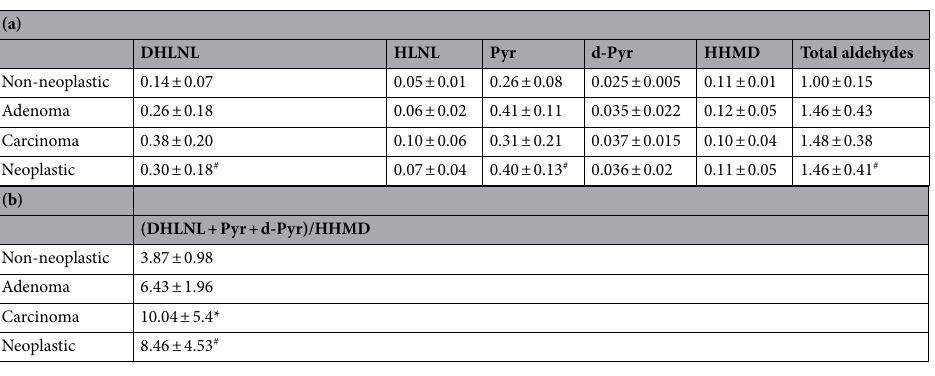
Table 5. Levels of immature reducible cross-links (DHLNL, HLNL, and HHMD) and mature non- reducible cross-links (Pry and d-Pyr) and their ratios. (a, b) DHLNL, dihydroxylysinonorleucine; HLNL, hydroxylysinonorleucine; HHMD, histidinohydroxymerodesmosine; Pyr, pyridinoline; d-Pyr, deoxypyridinoline. Total aldehydes = DHLNL + HLNL + 2 × Pyr + 2 × d-Pyr + 2 × HHMD. Values represent moles/mole collagen ± S.D (non-neoplastic, n = 5; adenoma, n = 7; carcinoma, n = 9; neoplastic, n = 16). * p < 0.05 between non-neoplastic and malignant (carcinoma) mammary gland tissues via Kruskal–Wallis followed by a Dunn’s multiple comparisons test. # p < 0.05 between non-neoplastic and neoplastic (combined adenoma and carcinoma) mammary gland tissues via unpaired Student’s t -tests.